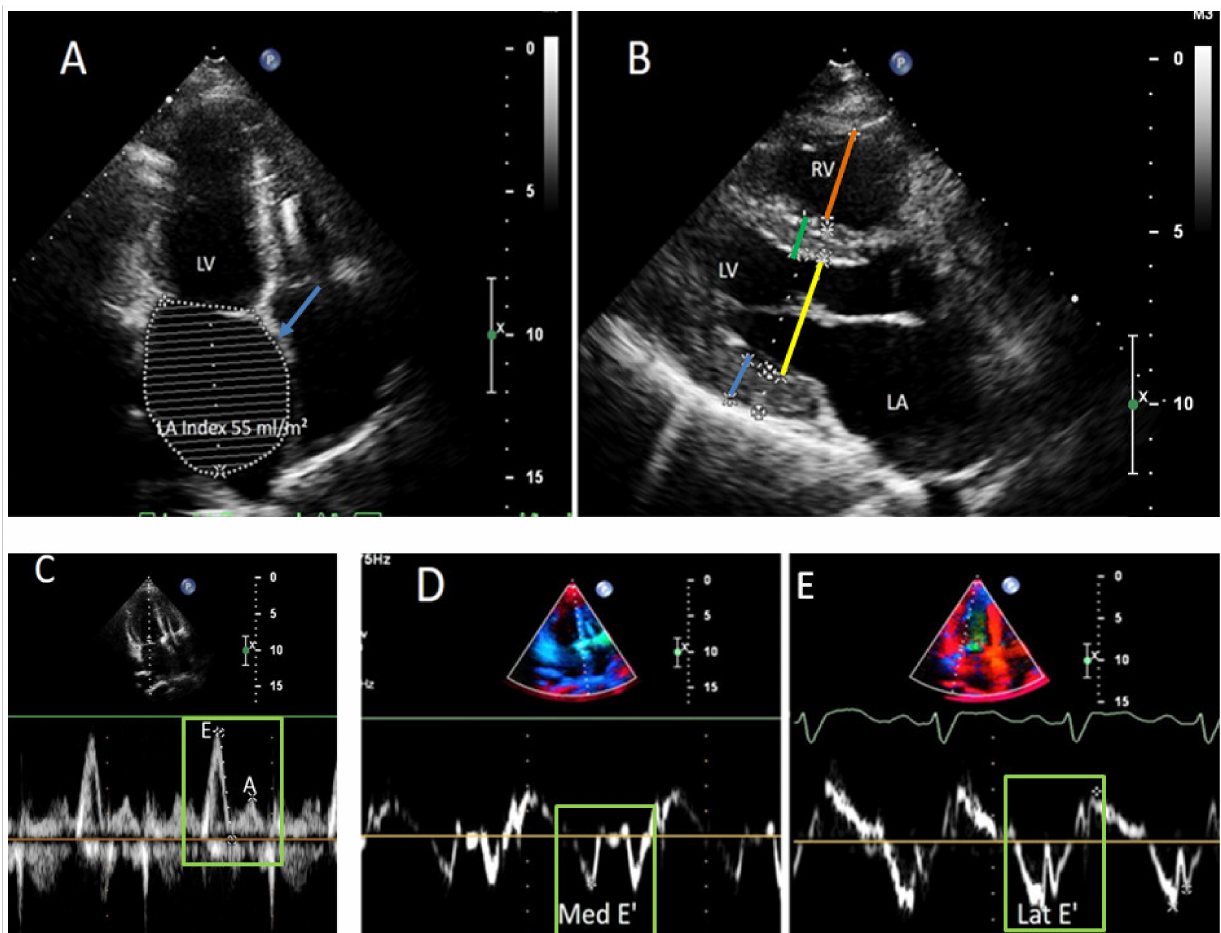
Figure 2. Echogardiograms of the patient on admission. ( A ) Apical two chambers view (left atrium (LA, indicated by blue arrow) volume index 55 mL/m 2 ). ( B ) Parasternal long-axis view (ventricular septum 1.2 cm (green line); left ventricular posterior wall 1.2 cm (blue line); right ventricular mid diameter 2.4 cm (orange line); left ventricular diameter 3.6 cm (yellow line). ( C ) Transmitral flow pattern (E: 113 cm/s; A: 39 cm/s; E/A 2.8; dt: 90 msec, flows are indicated by green rectangle). ( D , E ) Tissue Doppler (E med : 10 cm/s; E/E med : 10.6; E lat : 10–11 cm/s; E/E lat : 10.8; flows are indicated by green